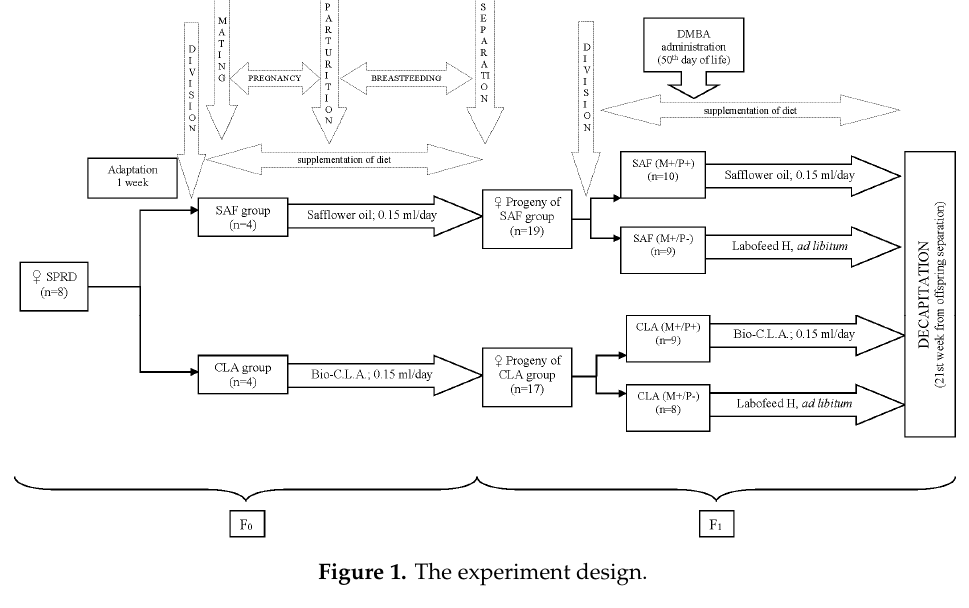
Figure 1. The experiment